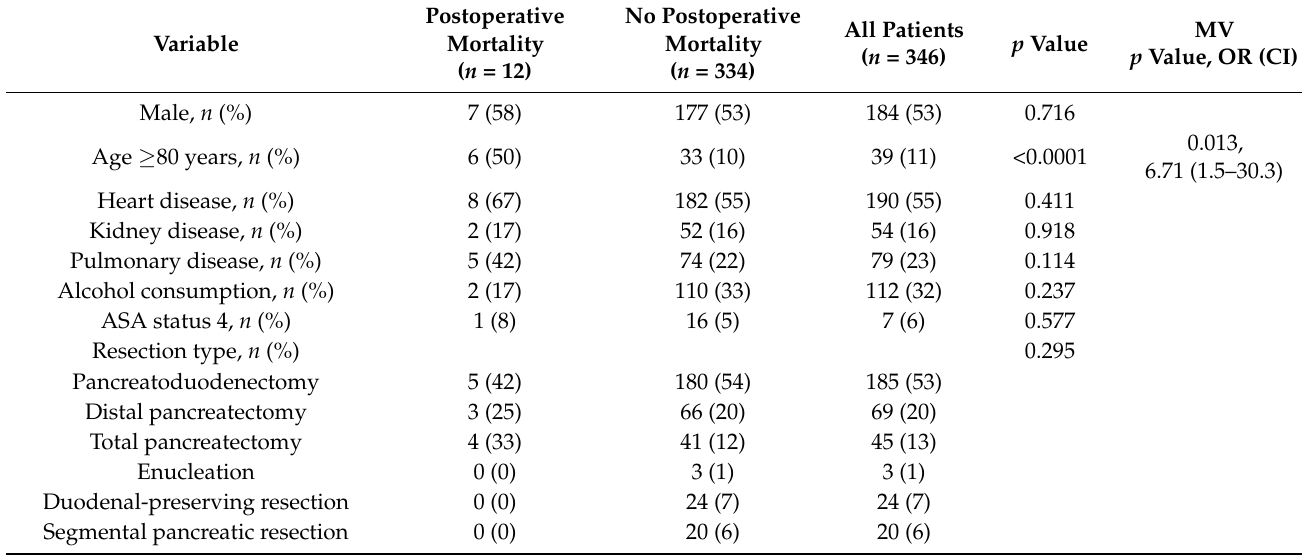
Table 4. Analysis of factors associated with postoperative mortality in 346 patients undergoing pancreatic surgery.